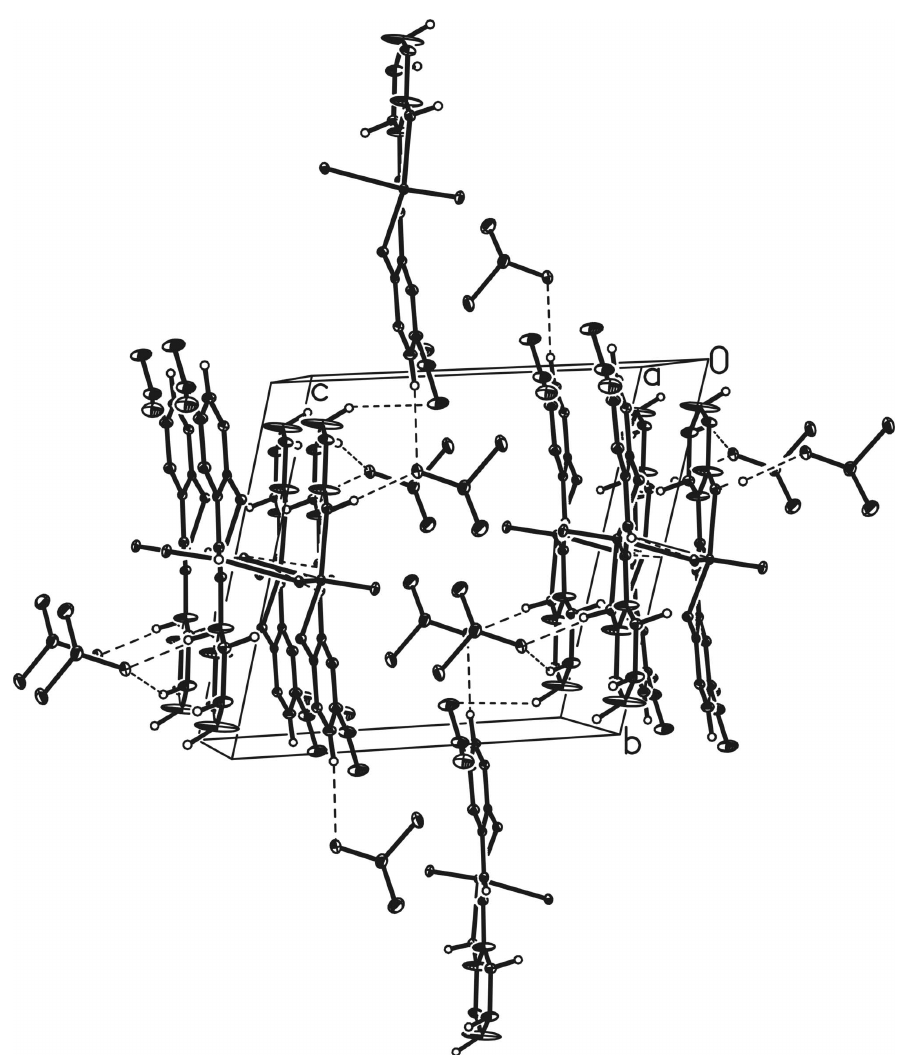
The arrangement of molecules in the title compound, viewed approximately along the a axis. Hydrogen bonds are represented by dashed